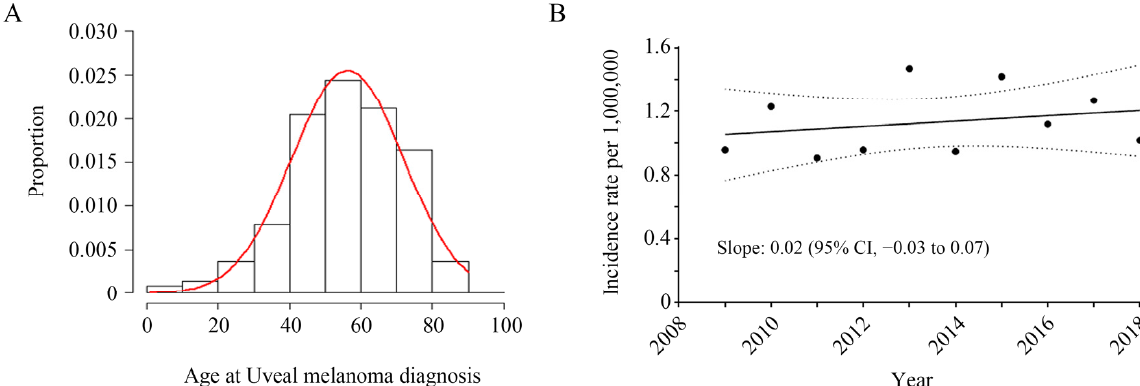
Figure 1. ( A ) Age distribution at diagnosis and ( B ) the annual incidence of uveal melanoma in Korea.